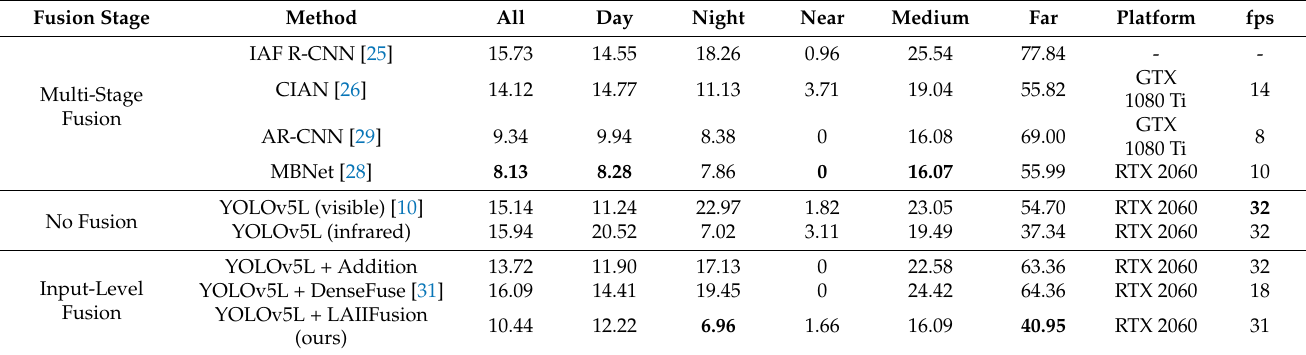
Table 3. Comparisons of detection performance on the KAIST dataset. In the ‘Platform’ column, NVIDIA GTX 1080 Ti has 11.3 T single-precision floating point operations (FLOPs), while